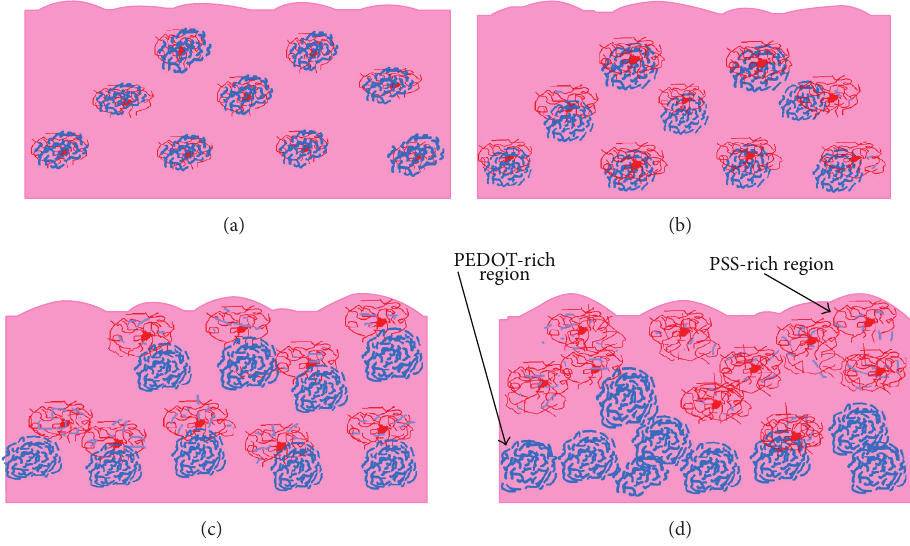
Figure 5: The schematic models of vertical phase separation with different deposition temperatures: (a) 70 ∘ C, (b) 100 ∘ C, (c) 130 ∘ C, and (d) 160 ∘ C.